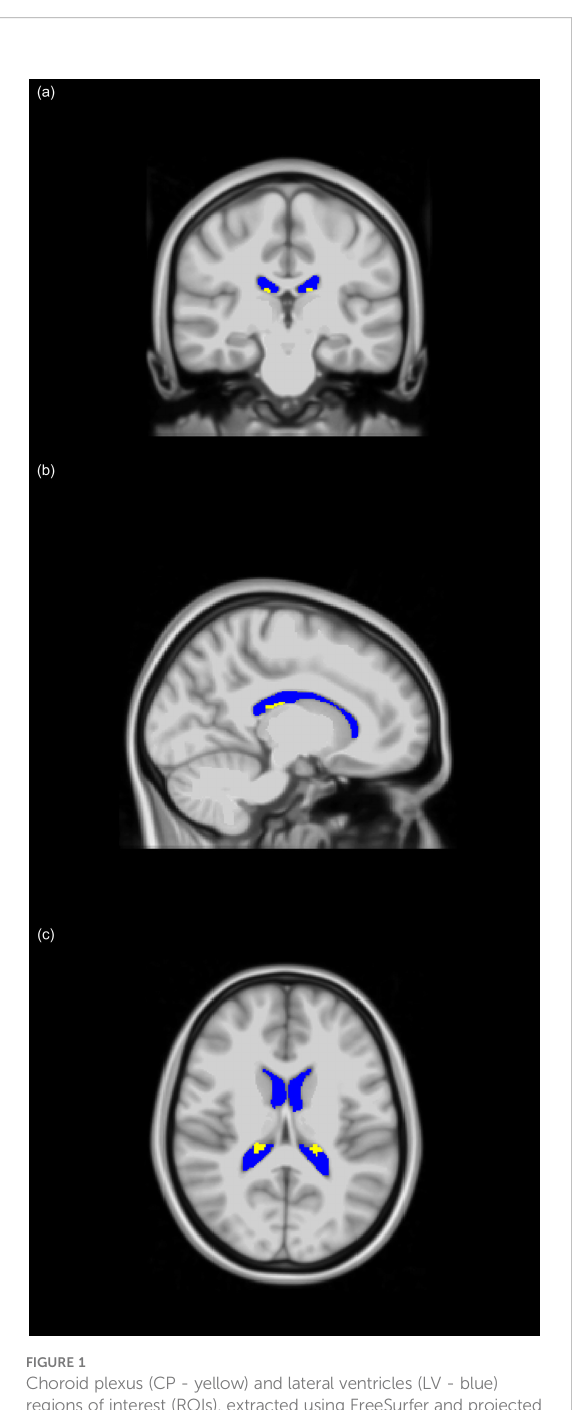
FIGURE 1 Choroid plexus (CP - yellow) and lateral ventricles (LV - blue) regions of interest (ROIs), extracted using FreeSurfer and projected on the MNI atlas for three different views: (A) coronal, (B) sagittal, and (C) axial. All images are in radiological